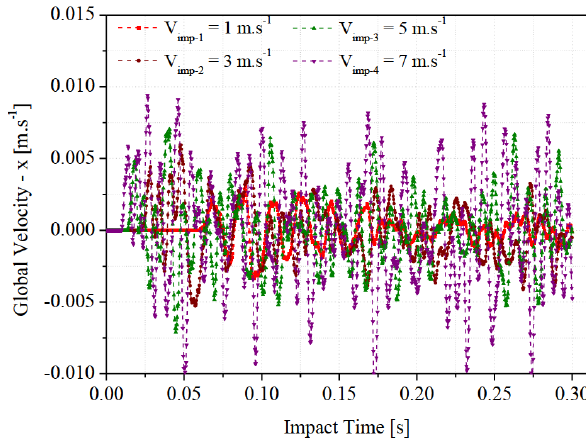
Figure 9: Global system velocity in impact: longitudinal direction (x-axis)